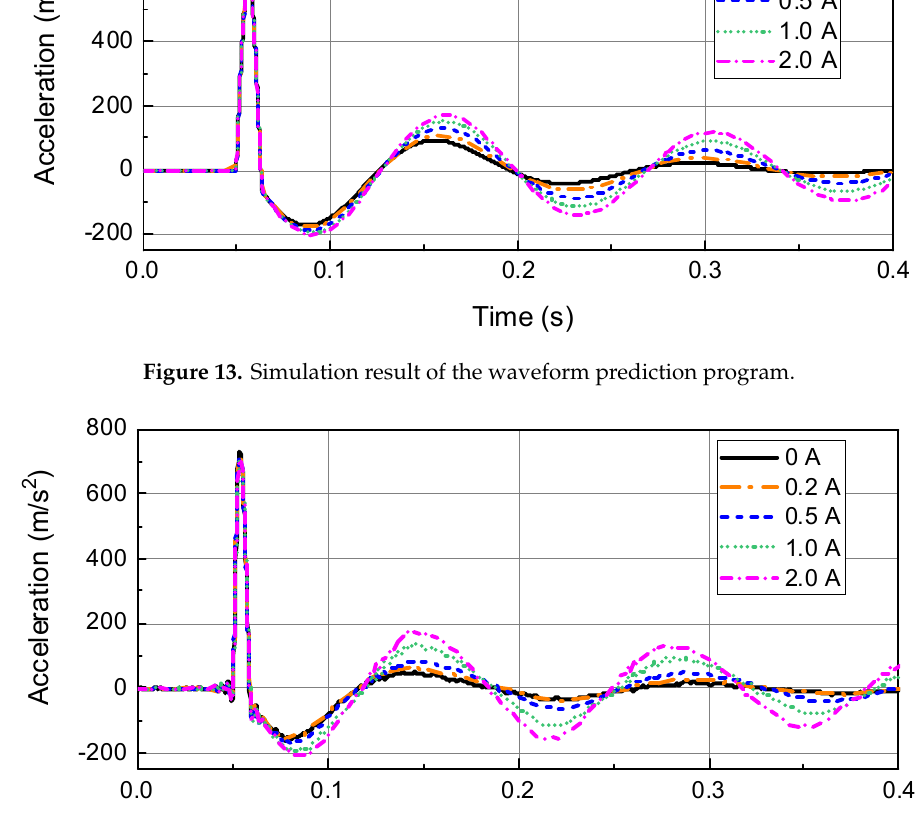
Figure 14. Experimental result of the waveform prediction program.